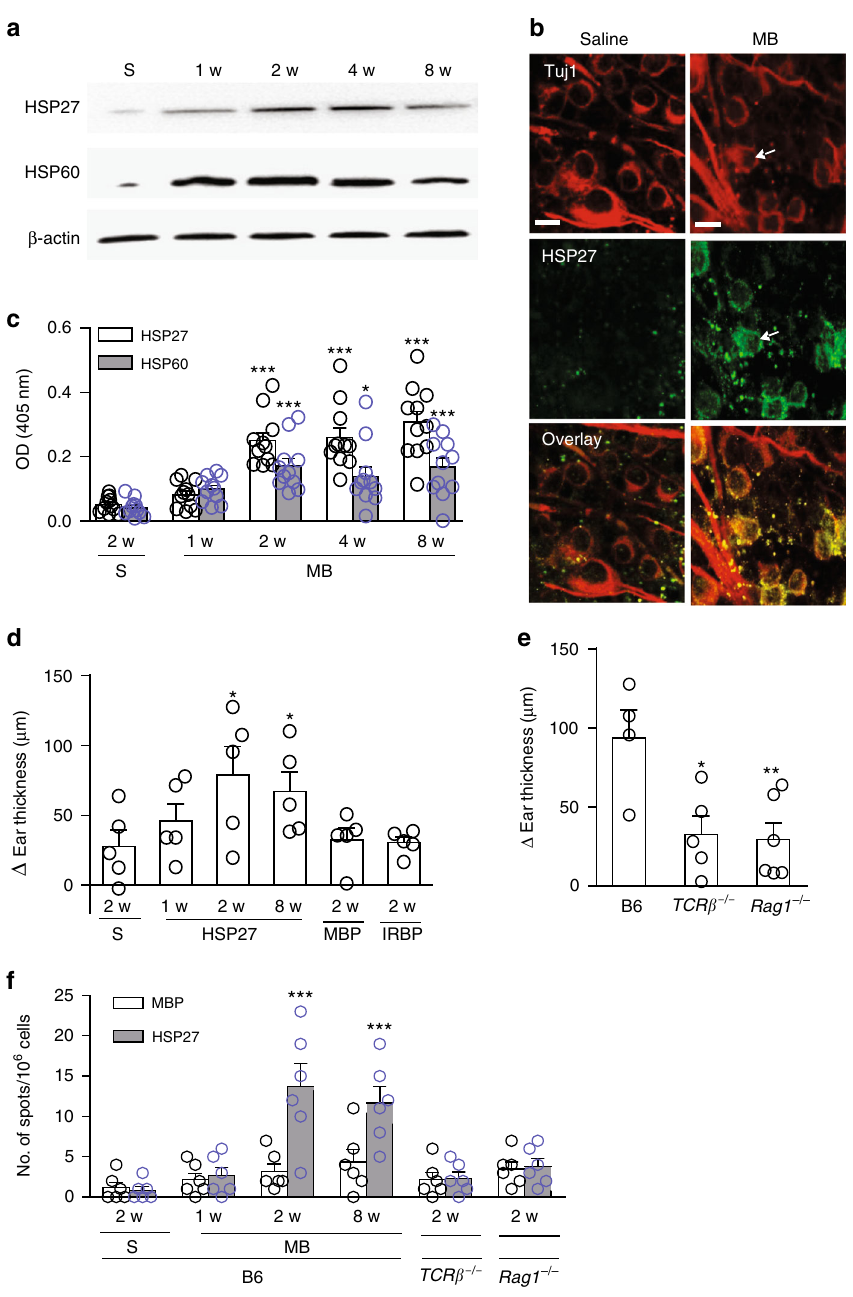
Fig. 3 Elevated IOP stimulates T-cell responses to HSPs. a Induction of HSP27 and HSP60 expression in the retinas following MB injection. B6 mice were injected with MB or saline and 1, 2, 4, and 8 weeks later retinas were harvested and homogenized. Cell homogenates were fractionated on SDS-PAGE and blotted with anti-HSP27, anti-HSP60, and anti- β -actin. Shown are representative western blots. b Upregulation of HSP27 in the glaucomatous retina. Retinal fl at-mounts were stained with Tuj1 (red) and anti-HSP27 (green). Shown are representative epi fl uorescence photomicrographs taken from mice 4 weeks post injection of saline or MB. Note the extracellular and membrane-associated HSP27 signals in the MB-injected retina. Scale bar: 10 μ m. c ELISA quanti fi cation of serum levels of antibodies speci fi c for HSP27 or HSP60 in B6 mice 1, 2, 3, and 4 weeks after MB injection or 2 weeks after saline (S) injection. * P < 0.05, *** P < 0.001 by ANOVA comparing to saline-injected group ( n = 10/group). d , e DTH assays for T-cell responses to HSP27. Shown are ear thickness among B6 mice under indicated conditions ( d ) or among B6, Rag1 − / − , and TCR β − / − mice 2 weeks after MB injection were compared ( e ). B6, Rag1 − / − , and TCR β − / − mice were injected with saline or MB in the anterior chamber of the eye. One, two, and eight weeks later mice were challenged with saline, HSP27, MBP, or IRBP, and ear thickness was measured 24 h later. * P < 0.05 by ANOVA compared to saline ( d ) or to HSP27 challenged B6 mice ( e ) ( n ≥ 4/group). f Frequencies of HSP27-speci fi c T-cell responses. B6, Rag1 − / − , and TCR β − / − mice were injected with saline or MB in the anterior chamber of the eye. One, two, and eight weeks later splenocytes were stimulated with HSP27 or MBP and the frequencies of IFN- γ -secreting cells were measured by ELISPOT. *** P < 0.001 by ANOVA as compared to saline- and MB-injected mice ( n ≥